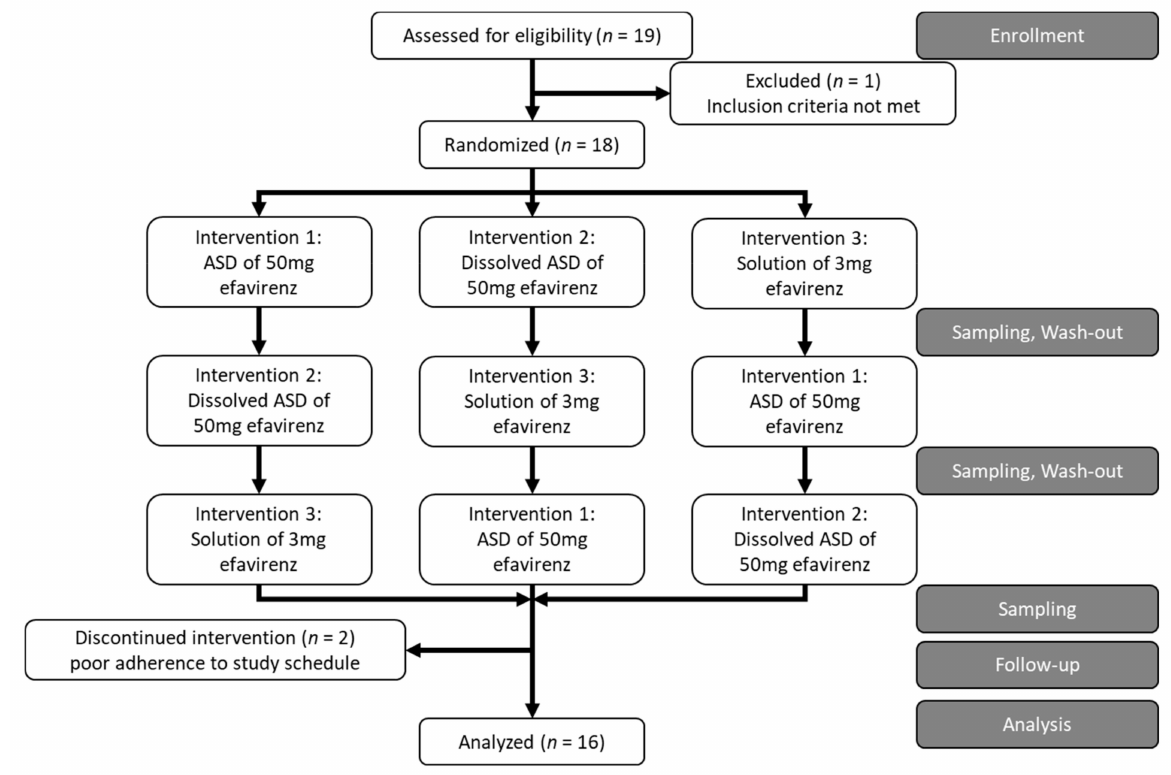
Figure 1. Study design according to the CONSORT Statement 2010